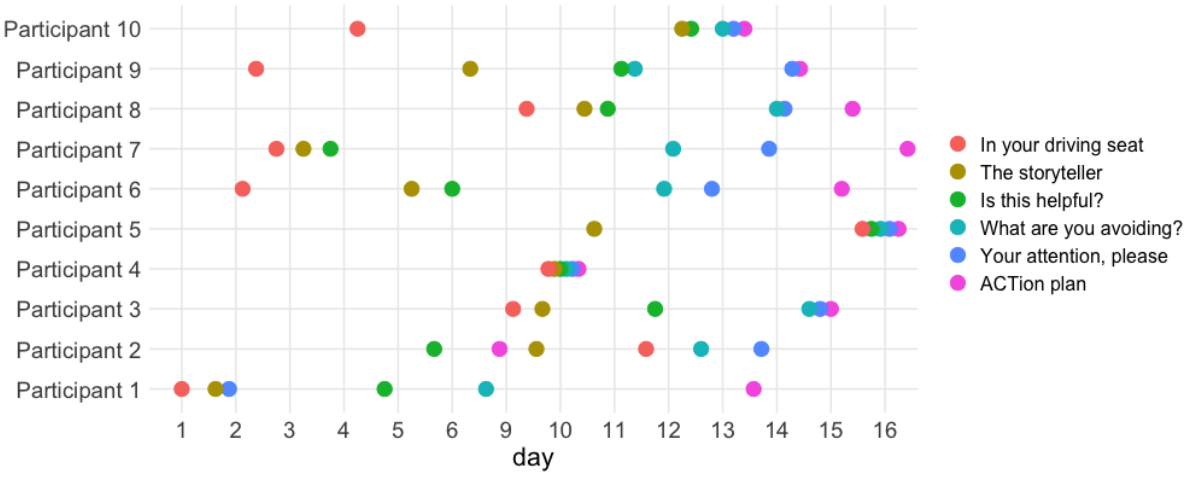
Figure 2. Completion order of ACT-based modules by participant. Participants onboarded onto the app over 2 days and had access to the app for 14